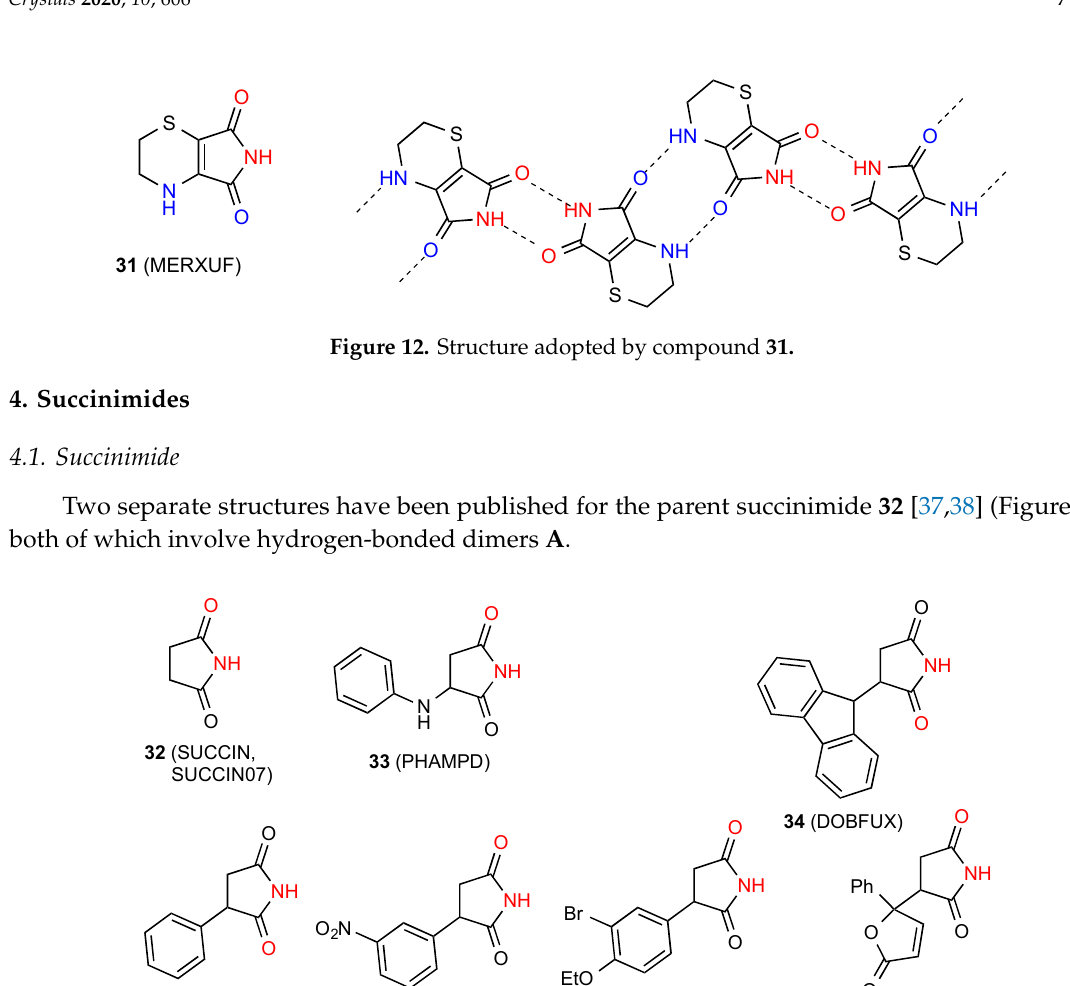
Figure 11. Structure adopted by compound 30.